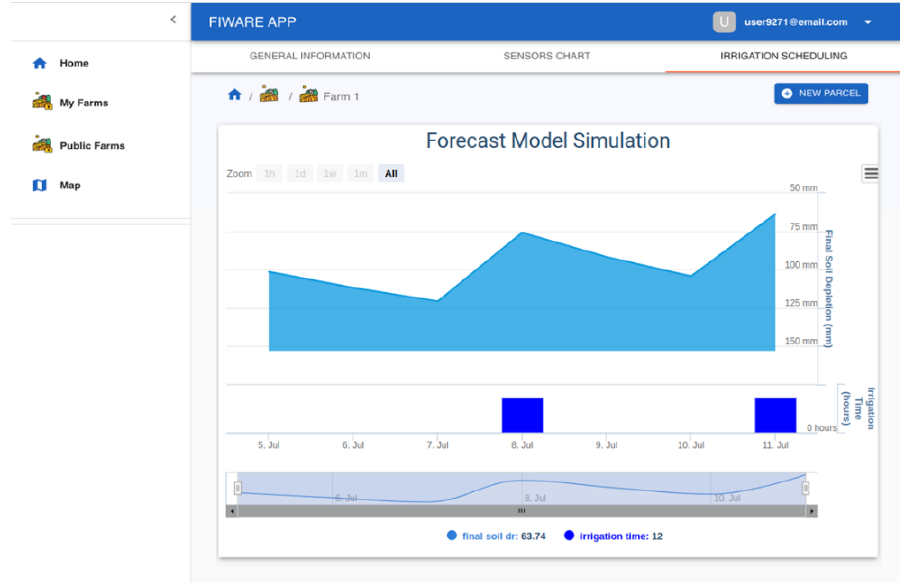
Figure 12. Simulation of the next seven days from the current day, showing water depletion in the root zone when using the strategy defined in Figure 10.